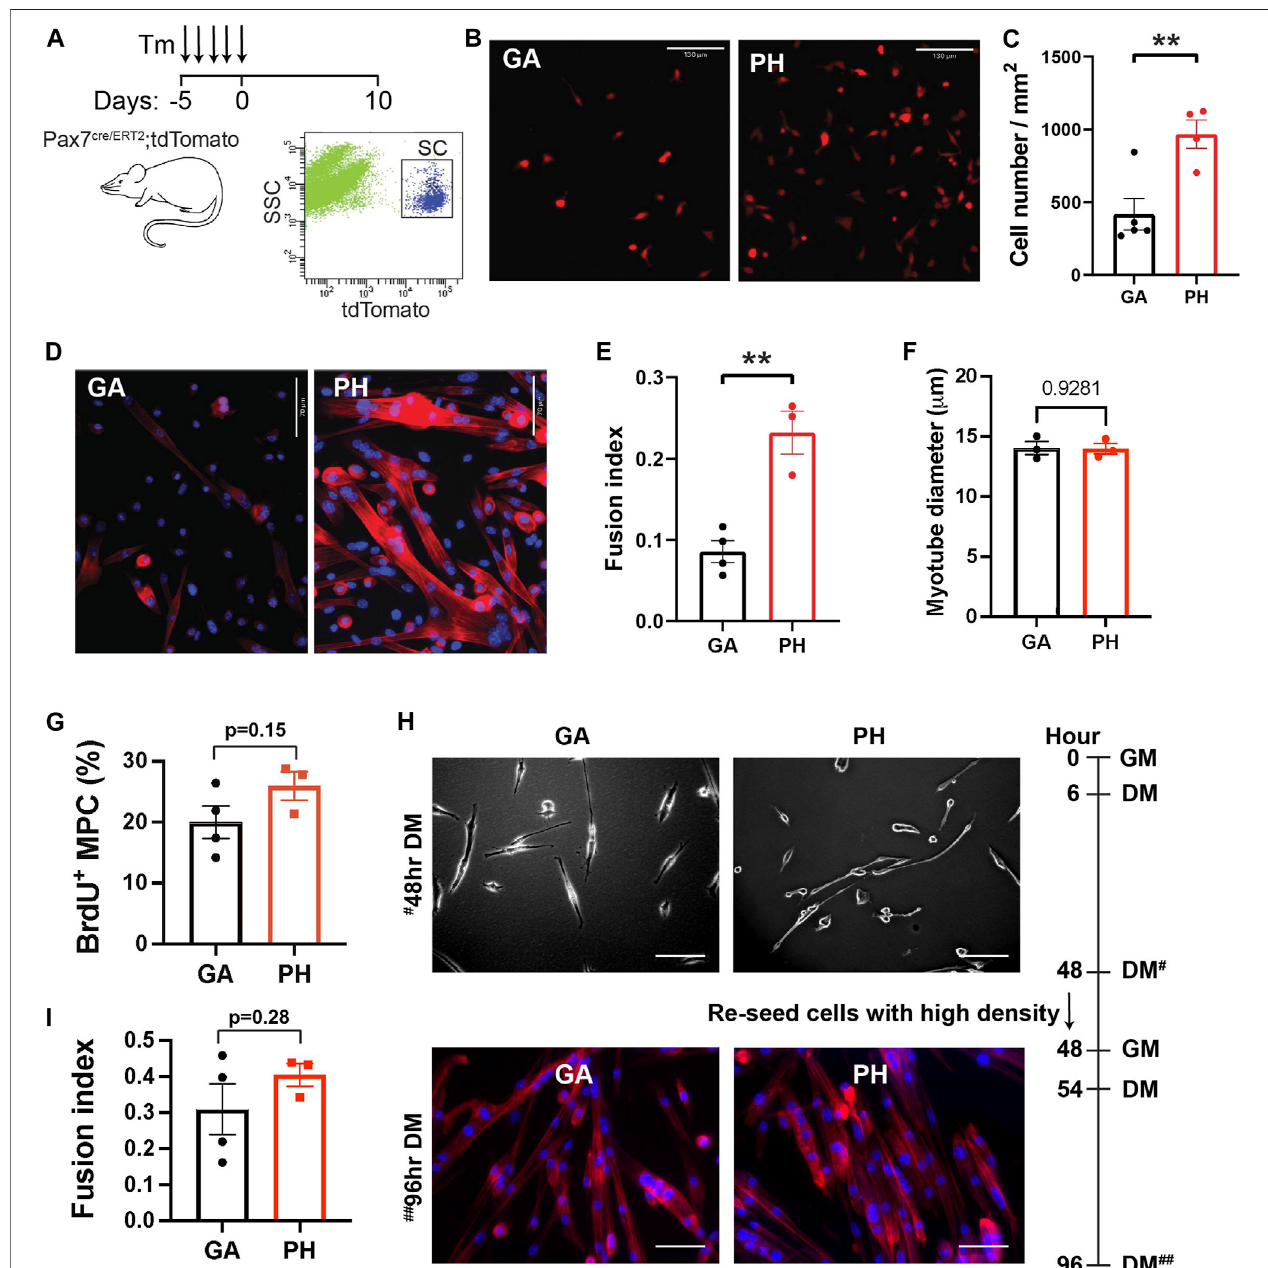
FIGURE 2 | High level of in vitro proliferation and differentiation of freshly isolated pharyngeal satellite cells but not pharyngeal myogenic progenitor cells. (A) Scheme of fl ow cytometry gating strategy for SC isolation using 3 months old Pax7 Cre ERT2 -tdTomato mice. (B) Representative image of 5-day cultured satellite cells derivedfrom thegastrocnemius (GA)and pharyngeal (PH) musclesof3 months Pax7 Cre ERT2 -tdTomato mice.Scale bars =130 µm. (C) Analysisofcellnumber/mm 2 in 5-dayculturedgastrocnemiusandpharyngealsatellitecells. n =4 – 5. (D) RepresentativePhalloidinstainedimage(red)of10-dayculturedsatellitecellsderivedfrom the gastrocnemius and pharyngeal muscles of 3 months Pax7 Cre ERT2 -tdTomato mice. Scale bars = 70 µm. The nucleus was stained by DAPI (blue). (E) Quanti fi ed fusion index at 10 days after culture. Fusion index was calculated as the percentage of total nuclei that resided in cells containing two or more nuclei. n = 3 – 4. (F) The diameterofmyotubeat10 daysafterculture. n =3,totalof148 GAmyotubesand353 PHmyotubeswereanalyzed. (G) PercentageofBrdU + myogenicprogenitorcells (MPCs) ingastrocnemius and pharyngeal musclesof3 monthsC57BL/6 old mice. n =3. (H) Representative image ofdifferentiated gastrocnemius (GA)and pharyngeal (PH)MPCsof3 monthsC57BL/6oldmice.Growthmedium(GM)waschangedtodifferentiationmedium(DM)6 hafterseeding.After fi rstseeding,cellswerere-seeded with high cell density in DM at 48 h # with GM, and medium was changed to DM at 54 h. Scale bars = 130 µm. (I) Quanti fi ed fusion index at 96 h ## . Fusion index was calculated as the percentage of total nuclei that resided in cells containing two or more nuclei. n = 3, total of 264 GA myotubes and 282 PH myotubes were analyzed. Statistical signi fi cance was determined by Student ’ s t-test (C, E, G, I) or by Mann-Whitney test (F) . For all graphs, the value represents mean ± SEM. Asterisks indicate statistical signi fi cance (** p <